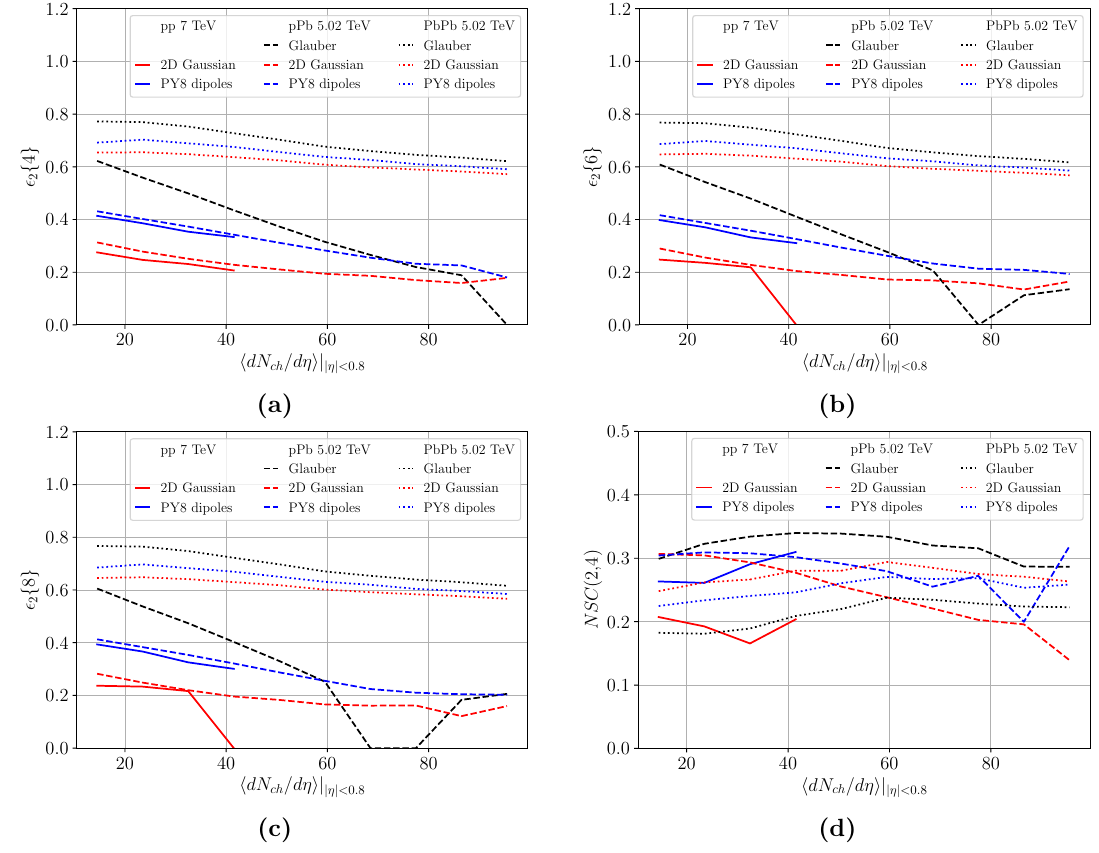
Figure 19. (a-c) The eccentricity (cid:15) 2 with higher order cumulants f 4 ; 6 ; 8 g . (d) The normalised symmetric cumulant NSC (4 ; 2) as a function of average multiplicity for pp ; pA ; AA systems.